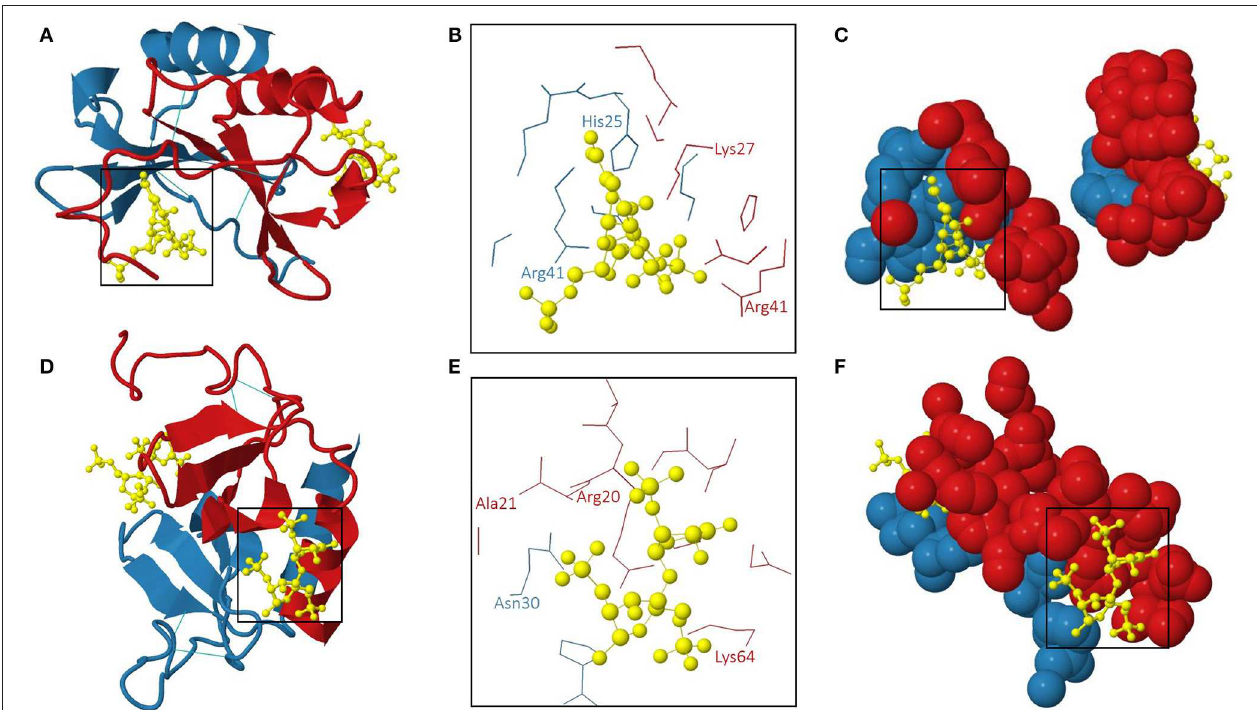
FIGURE 3 | The 3D structure of human CXCL12 dimer: heparin disaccharide complex (202). The 3D model (PDB accession code 2NWG) of the interaction of a human CXCL12 dimer with two heparin disaccharide molecules is shown from two different perspectives in (A–C) and (D–F) , respectively. (A,D) : overview; (B,E) : amino acids interacting with heparin disaccharide in the two binding pockets are indicated; (C,F) : 3D representation of the individual heparin disaccharide molecules in their binding pockets. The subunits of the CXCL12 dimer are displayed in red (subunit 1) and blue (subunit 2). The heparin disaccharide molecules and disulphide bridges are shown in yellow and light blue,